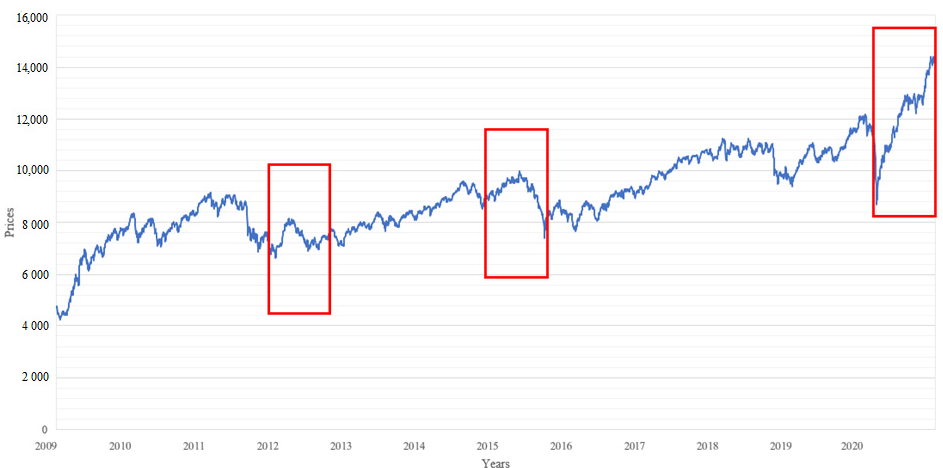
Figure 11. Taiwan stock market trends.